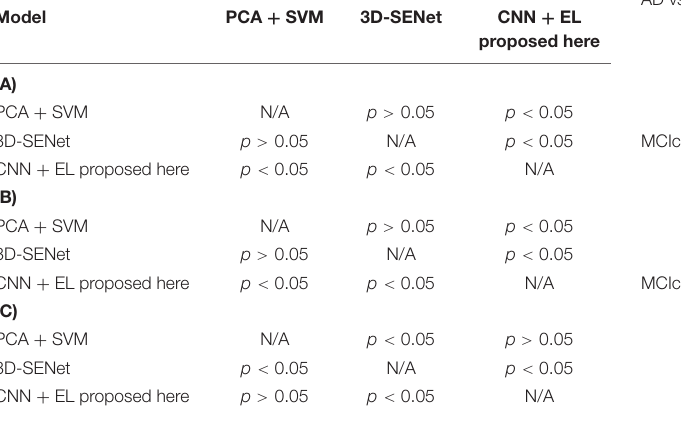
TABLE 6 | Statistical comparisons with p- values about accuracy mean of the three methods for (A) AD vs. HC task (upper panel), (B) MCIc vs. HC task (middle panel), and (C) MCIc vs. MCInc task (lower panel).